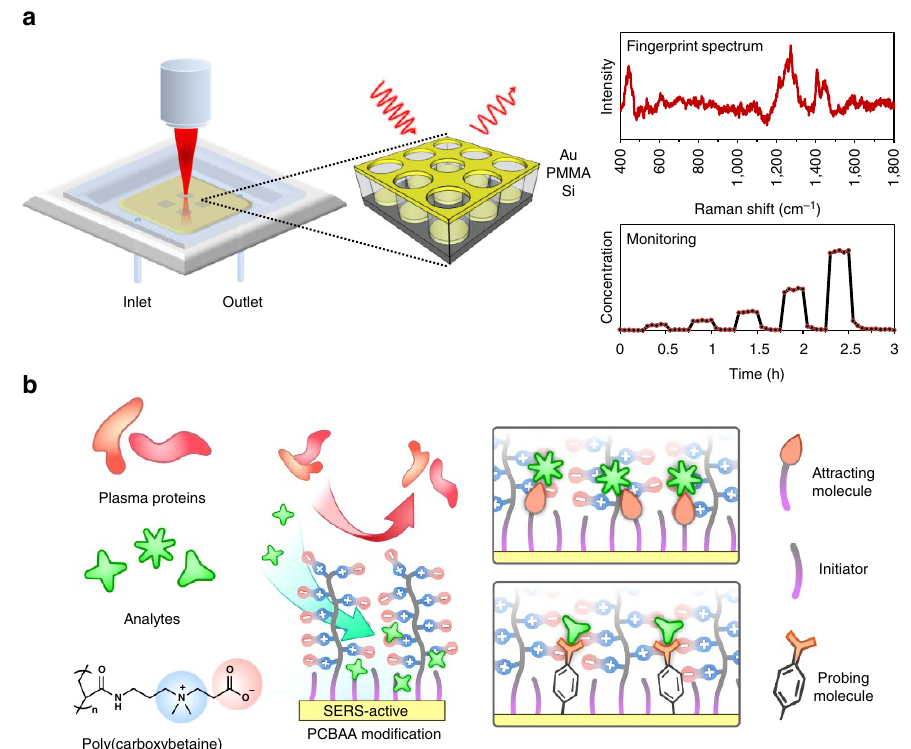
Figure 1 | Schematic of Q3D-PNAs SERS optofluidic system and hierarchical zwitterionic surface modifications. ( a ) Schematic of SERS optofluidic system incorporating a Q3D-PNAs SERS substrate to provide fingerprint spectra of analytes and quantitative, real-time monitoring. ( b ) Schematic of hierarchical pCBAA-based zwitterionic non-fouling modification on the SERS-active surface. Top: mixed SAM containing initiators and ‘attracting’ molecules, which have terminal functional groups that physically attract analytes to the surface for direct SERS detection. Bottom: mixed SAM containing initiators and ‘probing’ molecules (Raman reporters), which have functional groups that chemically interact with analytes to facilitate indirect analyte detection by monitoring changes in the SERS spectra of the Fig. 2a) and 111 ng cm (cid:2) 2 of protein fouling was confirmed using an SPR sensor (Supplementary Fig. 2c). Both SERS and SPR results indicate that this short OEG SAM was insufficient to